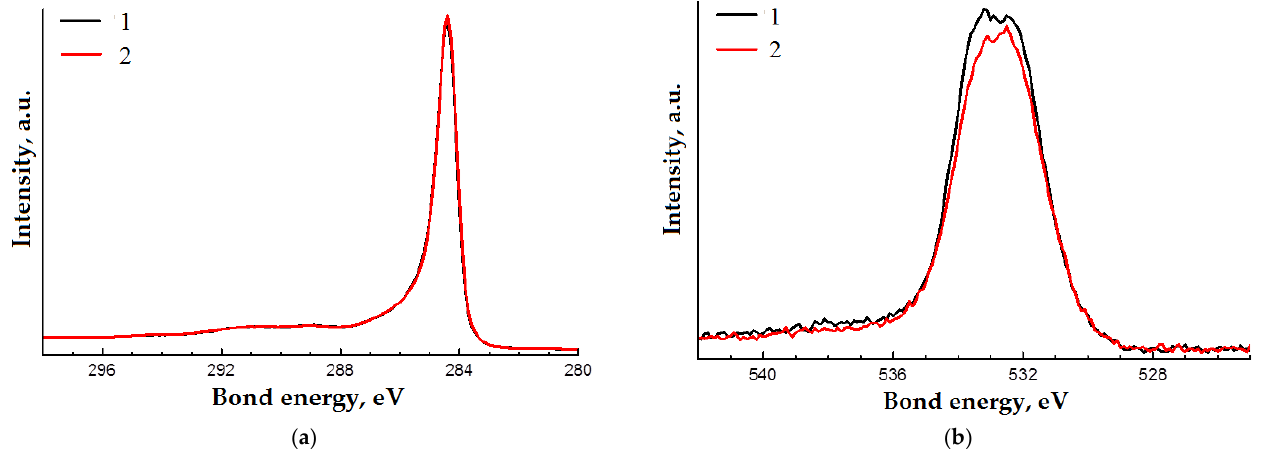
Figure 9. C1s ( a ) and O1s ( b ) XPS spectra of initial CNTs (1) and CNTs after RESS (2).